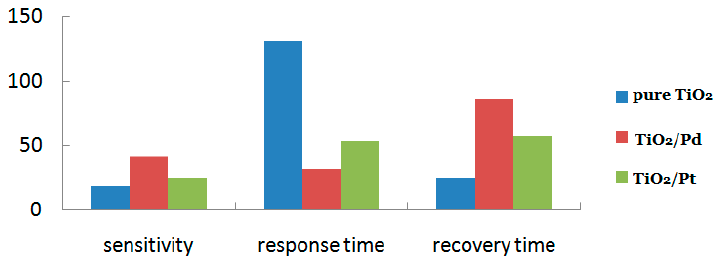
Figure 17. Results of different samples toward 500 ppm H (cid:2870) at 180 ℃ in Esfandiar's experiments.